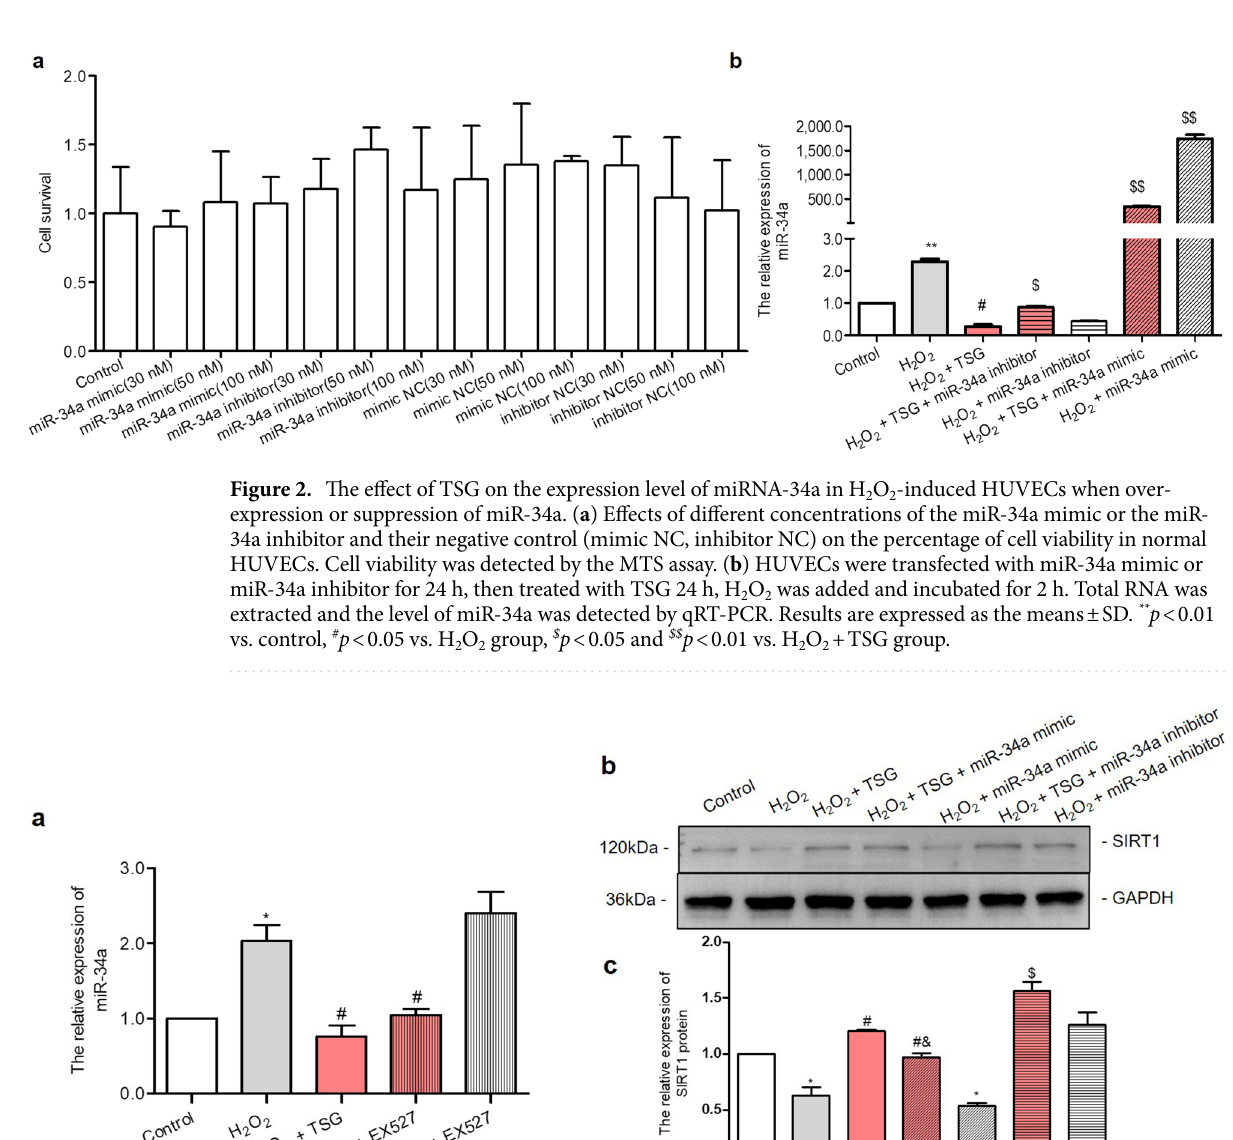
of them had an enhanced effect. Whereas, compared with H 2 O 2 + TSG group, over-expression of miR-34a by miR-34a mimic increased the number of apoptosis cells, and could significantly reverse the down-regulation of TSG on cell apoptosis. These data indicated that TSG alleviated cell apoptosis through miR-34a.